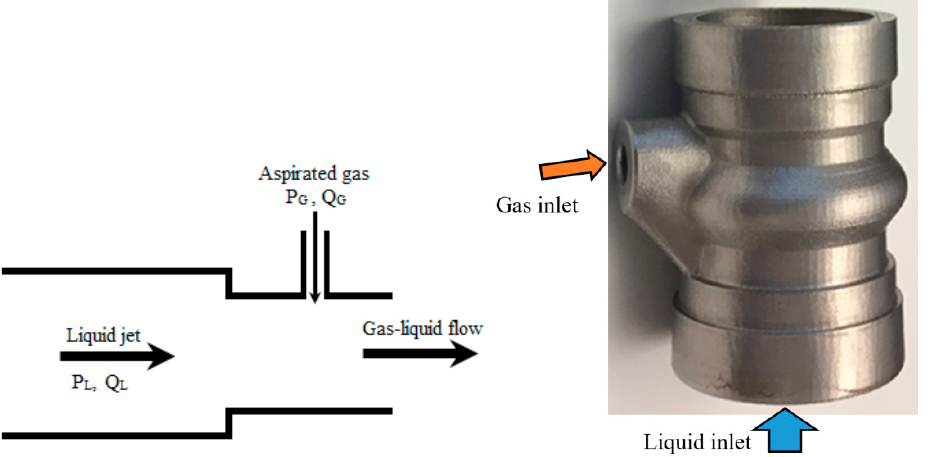
Figure 1. Liquid ejector principle ( left ) (modified from [20]) and the auto-aspirated sparger printed in metal with labelled inlet streams ( right ). Sparger length: 100 mm, sparger diameter: 60 mm. 𝑃 (cid:3013) , 𝑃 (cid:3008) , and 𝑄 (cid:3013) , 𝑄 (cid:3008) are the pressure and flow rates of liquid and gas